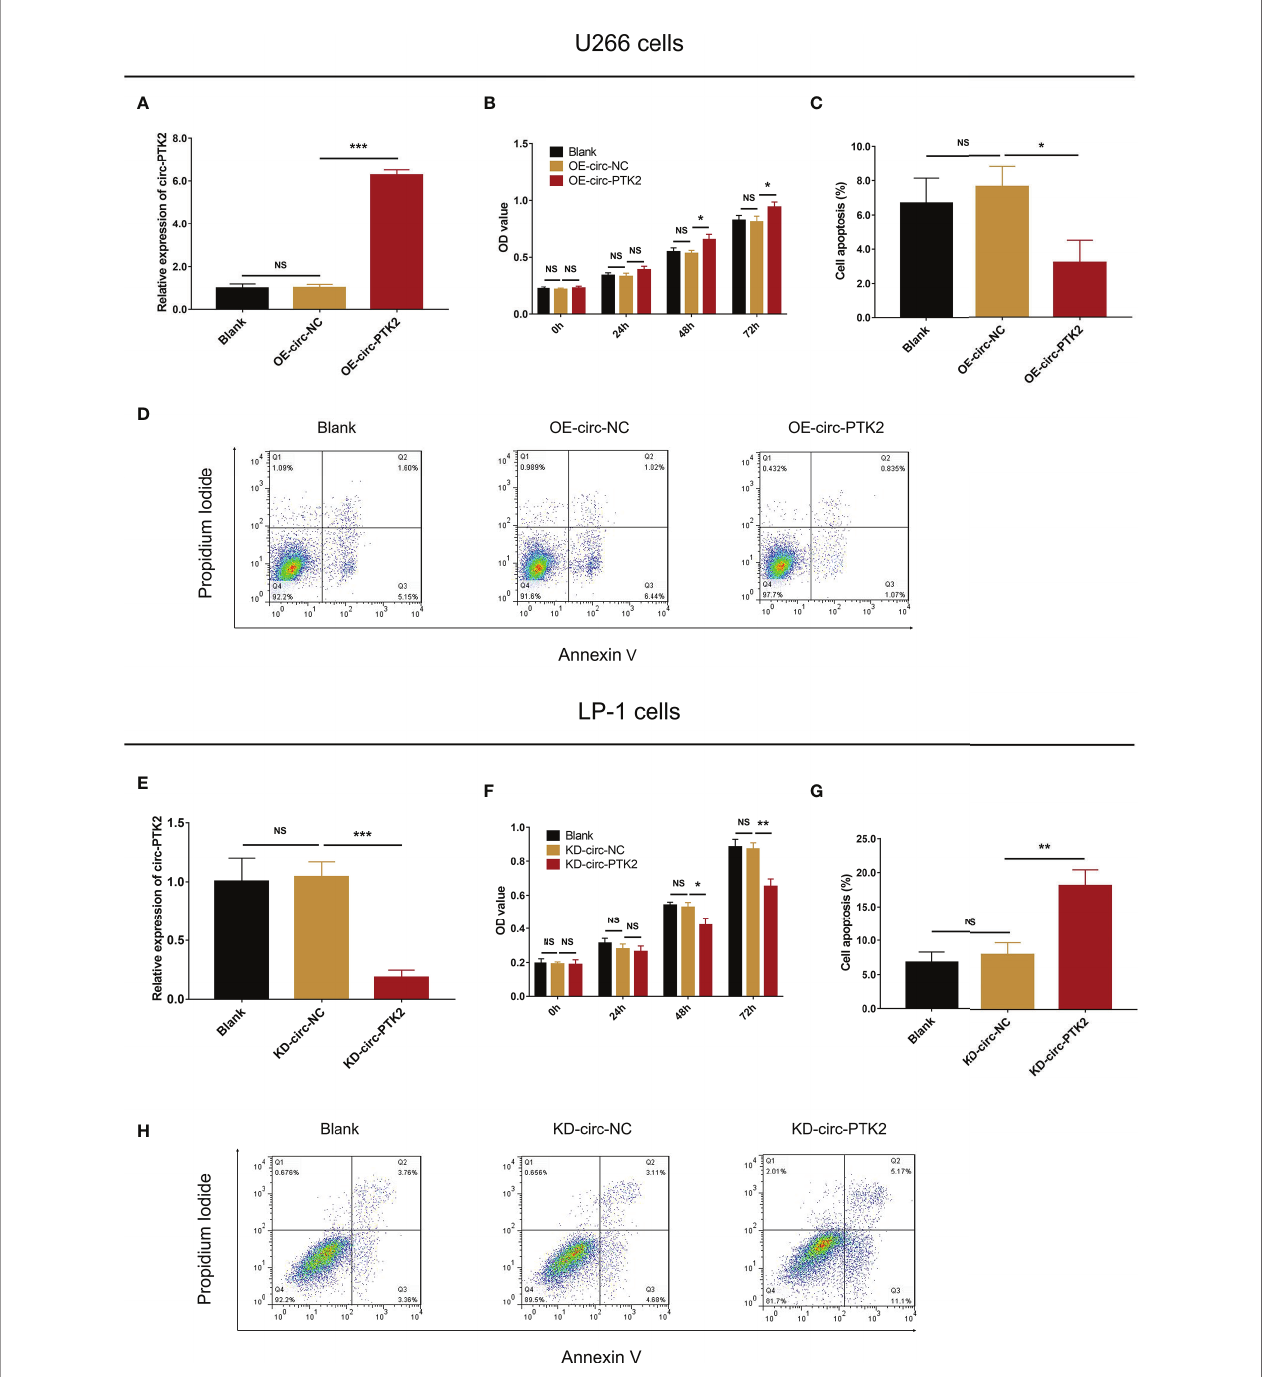
FIGURE 2 | Circ-PTK2 promoted proliferation and suppressed apoptosis of MM cells. The effect of circ-PTK2 overexpression plasmid transfection on circ-PTK2 expression (A) , cell proliferation (B) and apoptosis (C, D) were detected by RT-qPCR, CCK-8 and AV/PI assays in U226 cells. The effect of circ-PTK2 knock-out plasmid transfection on circ-PTK2 expression (E) , cell proliferation (F) and apoptosis (G, H) were detected by RT-qPCR, CCK-8 and AV/PI assays in LP-1 cells. Circ-PTK2, circular RNA protein tyrosine kinase 2; MM, multiple myeloma; OD, optical density; NS, non-signi fi cant; OE-circ-NC, circRNA control overexpression; OE- circ-PTK2, circ-PTK2 overexpression; KD-circ-NC, circRNA control knock-down; KD-circ-PTK2, circ-PTK2 knock-down; RT-qPCR, reverse transcription quantitative polymerase chain reaction; CCK-8, counting kit-8; AV/PI, Annexin V/Propidium Iodide; * P < 0.05; ** P < 0.01; *** P < 0.001. RNA expression was normalized by 2 -